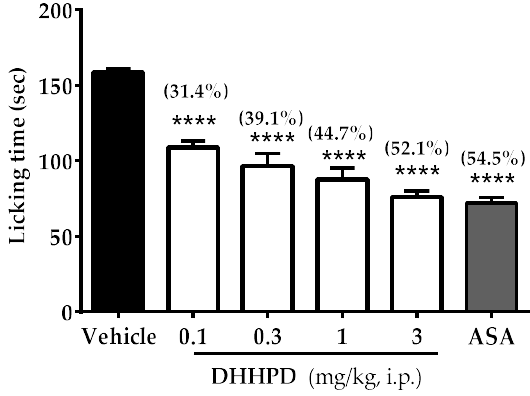
Figure 5. Effect of DHHPD against glutamate-induced paw licking test in mice. Each column represents the mean ± SEM ( n = 6). The asterisks (*) denote the significance level as compared to the vehicle group, **** p < 0.0001 by one-way ANOVA followed by Dunnett’s post hoc test. Mice were pre-treated with vehicle (10 mL/kg, i.p.), acetylsalicylic acid (ASA, 100 mg/kg, i.p.) and DHHPD (0.1, 0.3, 1 and 3 mg/kg, i.p.).